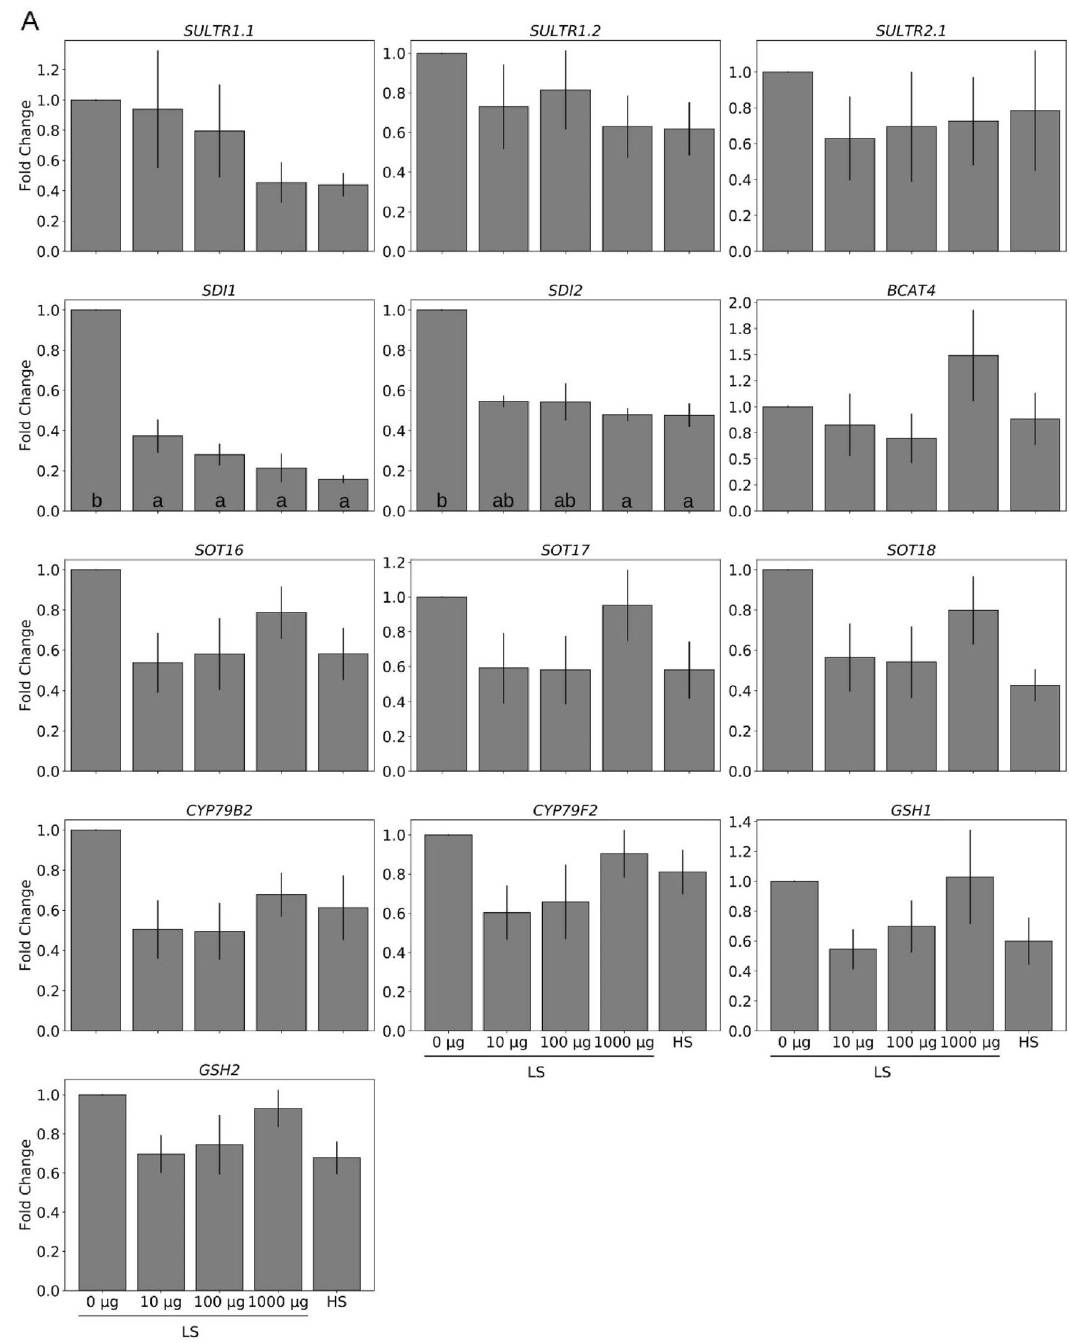
Figure 5. TMTM reduces plant response towards sulfur deficiency. Gene expression was analyzed 2 days ( A ) and 7 days ( B ) after TMTM application. Values were normalized to seedlings grown on low sulfate (LS) MGRL medium without TMTM (0 µg), and expressed as fold change. RNA from each treatment was extracted from total seedlings (combining root and shoot). Error bars represent SEs from 3 biological replicates, each with 8 seedlings. Statistical significance was conducted on dCq values, determined by Duncan’s multiple range test with p-value < 0.05, and indicated with lower-case